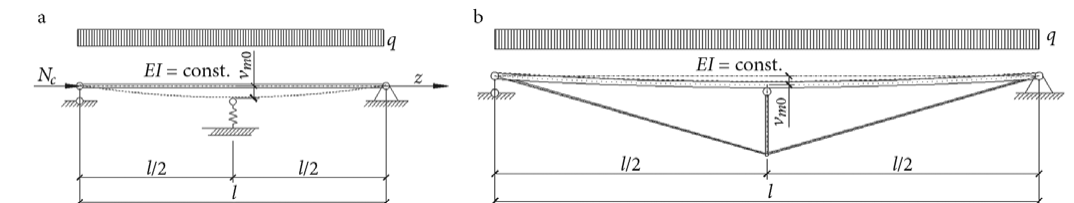
Fig. 1. Underslung girder bridge: a – mathematical model; b – calculation